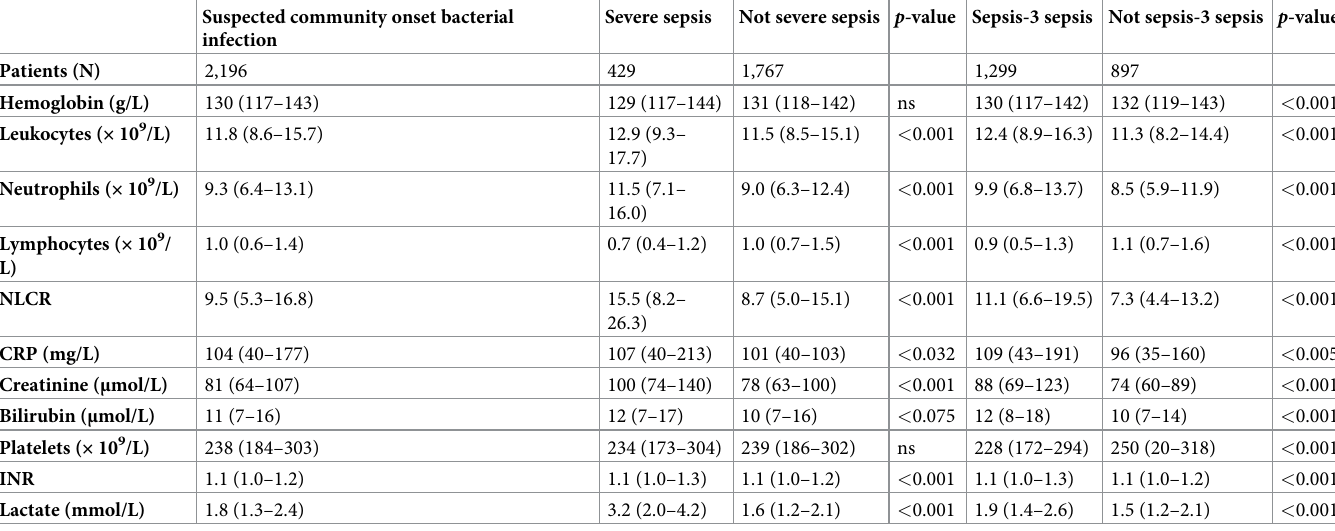
Table 3. Laboratory results at baseline for 2,196 consecutive adult patients admitted with suspected community onset bacterial infection. Results are presented also for patients with severe sepsis and Sepsis-3 sepsis. Values listed are medians (IQR) 1 . Suspected community onset bacterial infection